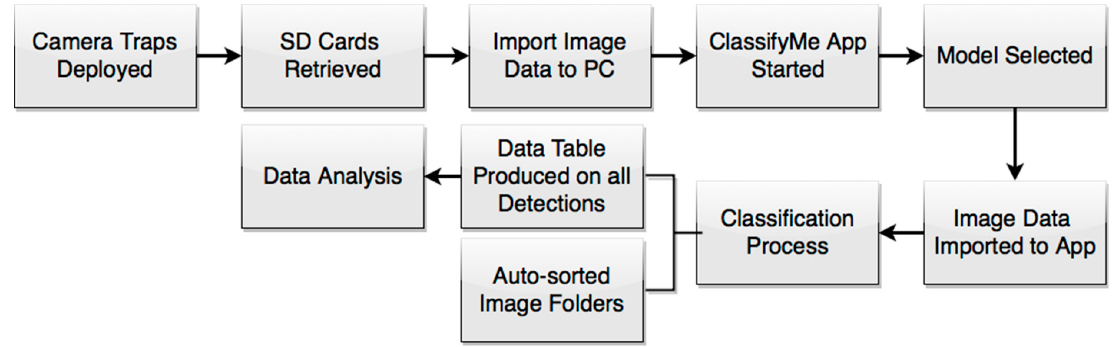
Figure 1. The data collection-analysis pipeline using the ClassifyMe software.